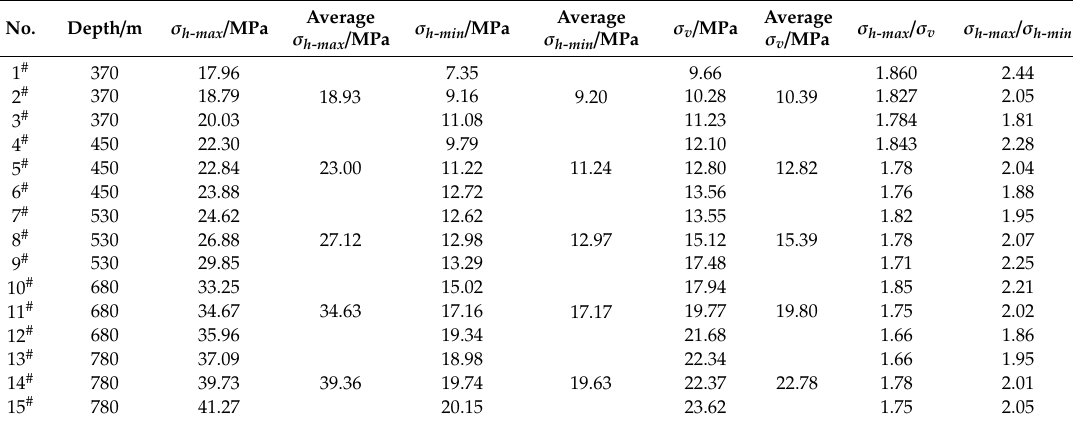
Table 1. In situ stresses of each measurement